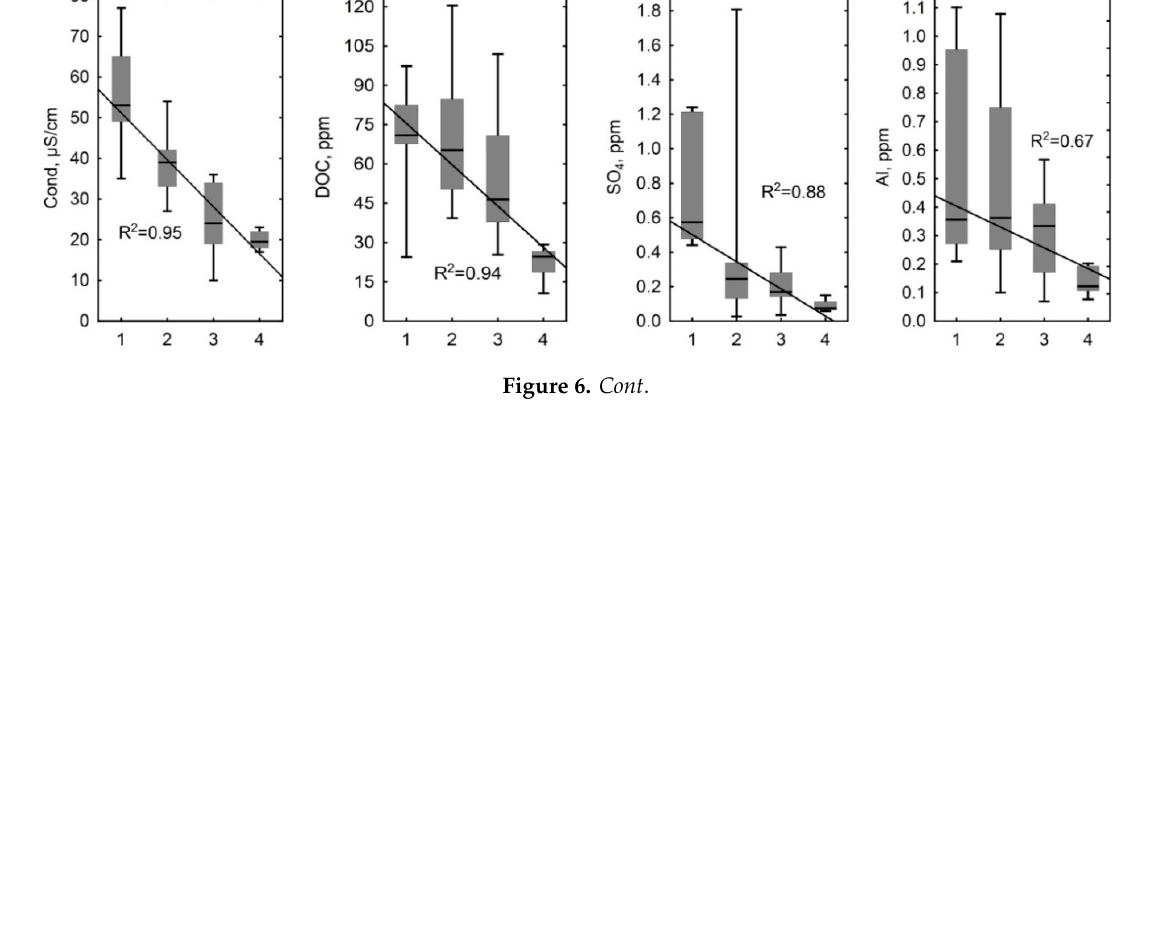
Figure 5. Microtopes of the polygonal bog with a different hydrological regimes of the key site (KS) Tazovsky (Taz). Legend: 1—polygons of elevated dry positions; 2—degraded and flooded polygons